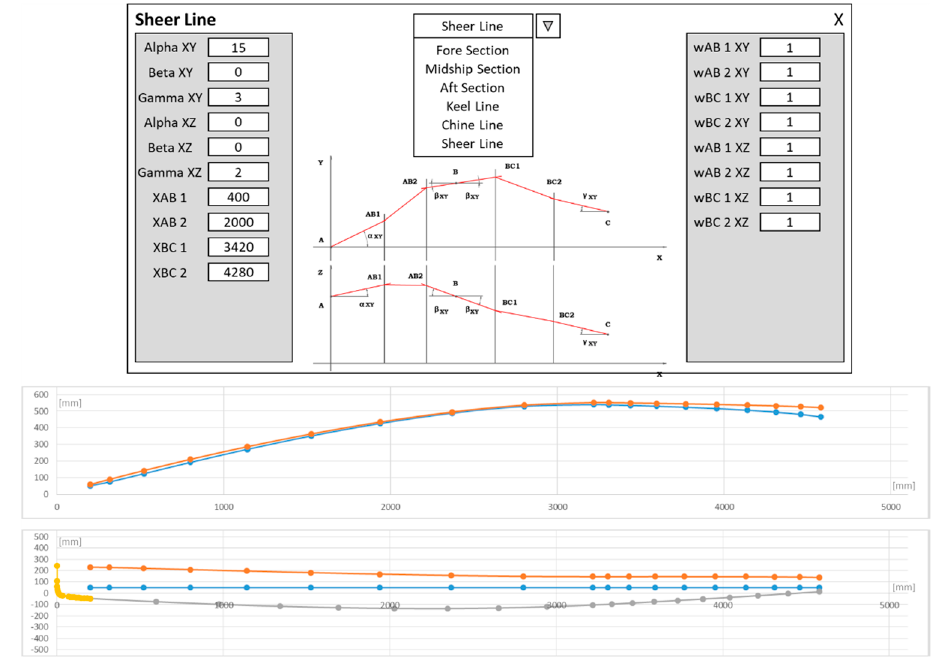
Figure 7. User-interface of a section.